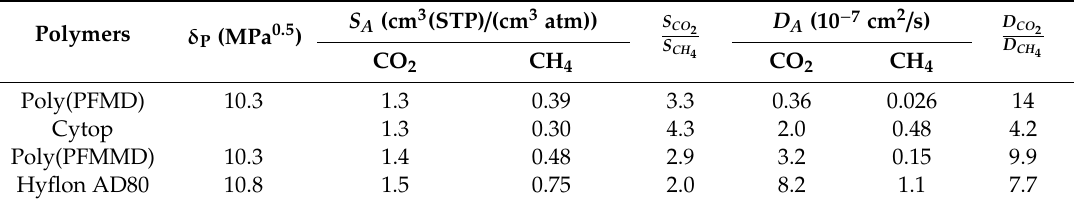
Table 4. Comparison of Solubility Parameter ( δ P ), Gas Solubility, and Di ff usivity in Poly(PFMD), Poly(PFMMD), Cytop, and Hyflon AD80 at 10 atm and 35 ◦ C